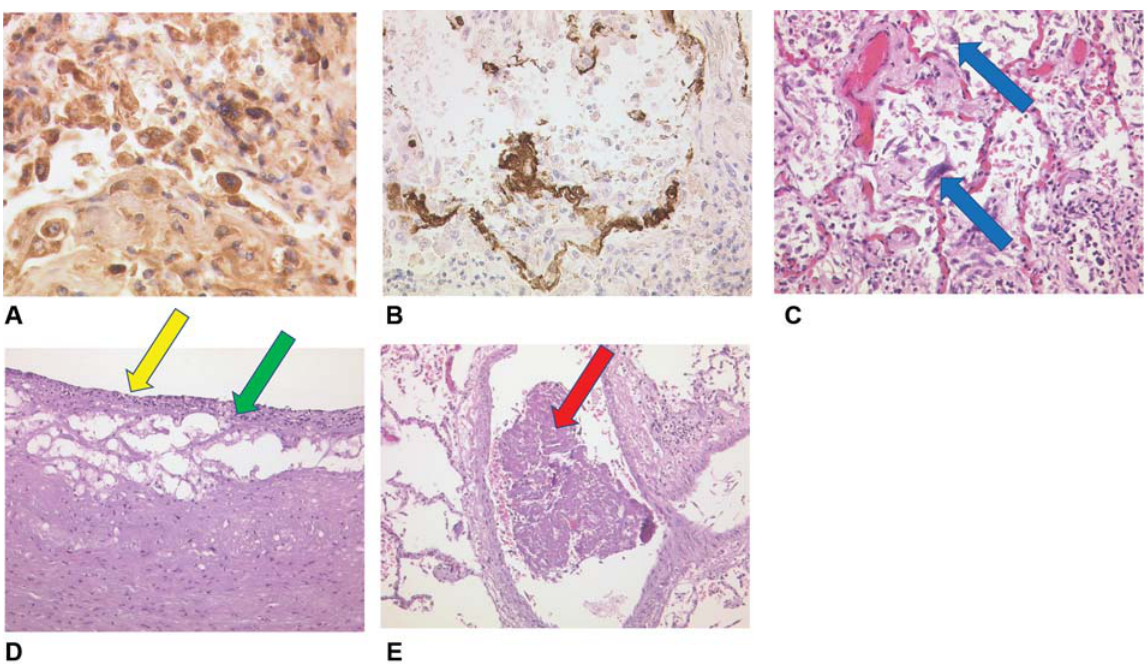
Fig. 5 ( A ) Lung tissue with IL-6 expression (brown colored stain) of plasma cells and alveolar macrophages (pneumocytes II, IL-6, Zytomed), (cid:1) 80 magni fi cation. ( B ) Lung tissue with MCP-1 expression (brown colored stain) in alveolar macrophages (pneumocytes II) and intra-alveolar fi brin (MCP-1, Santa Cruz), (cid:1) 40 magni fi cation. ( C ) The novel coronavirus disease (COVID-19) lung with activated intra-alveolar pneumocytes type II, some with virally altered multiple nuclei (blue arrow), H&E, (cid:1) 20 magni fi cation. ( D ) Left arteria carotis communis with endothelial damage (yellow arrow), necroses, fi brinous exsudation and in fl ammatory in fi ltrates of the intimal layer (green arrow), H&E, (cid:1) 40 magni fi cation. ( E